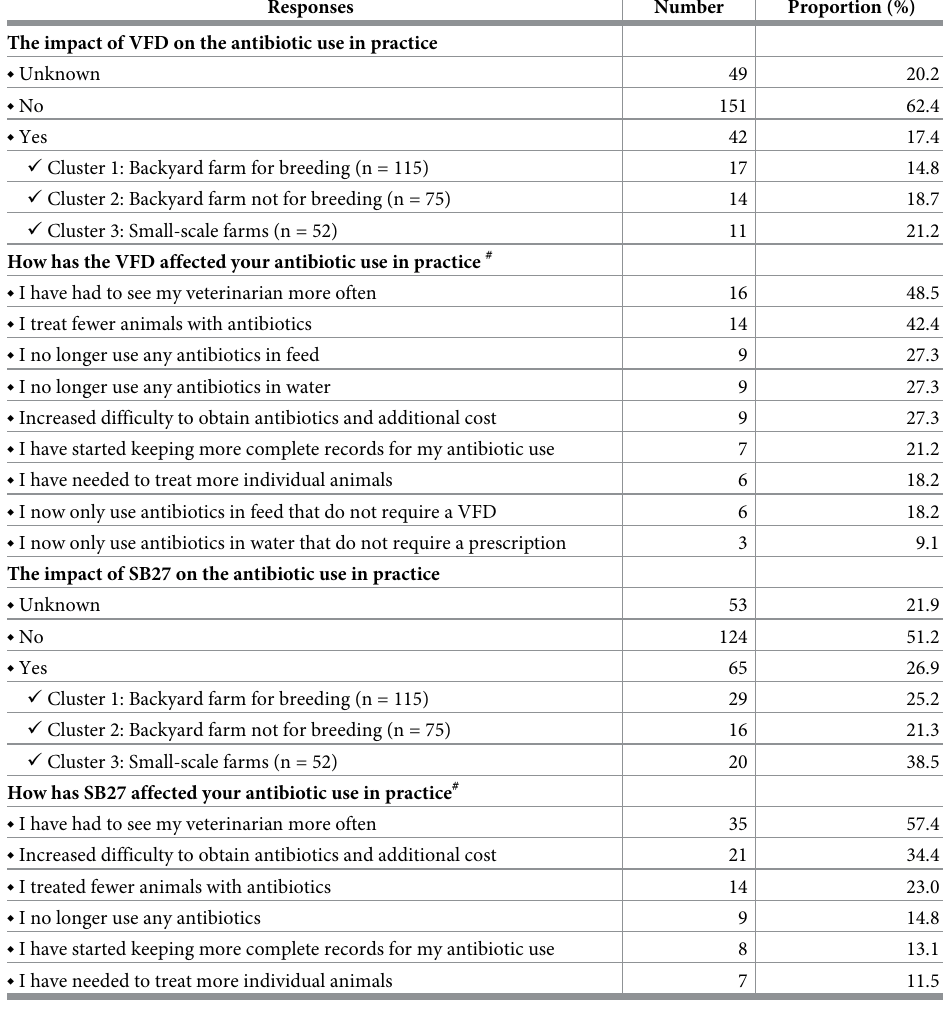
Table 5. Summary of the impact of veterinary feed directive (VFD) and SB27 on the antibiotic use. Responses Number Proportion